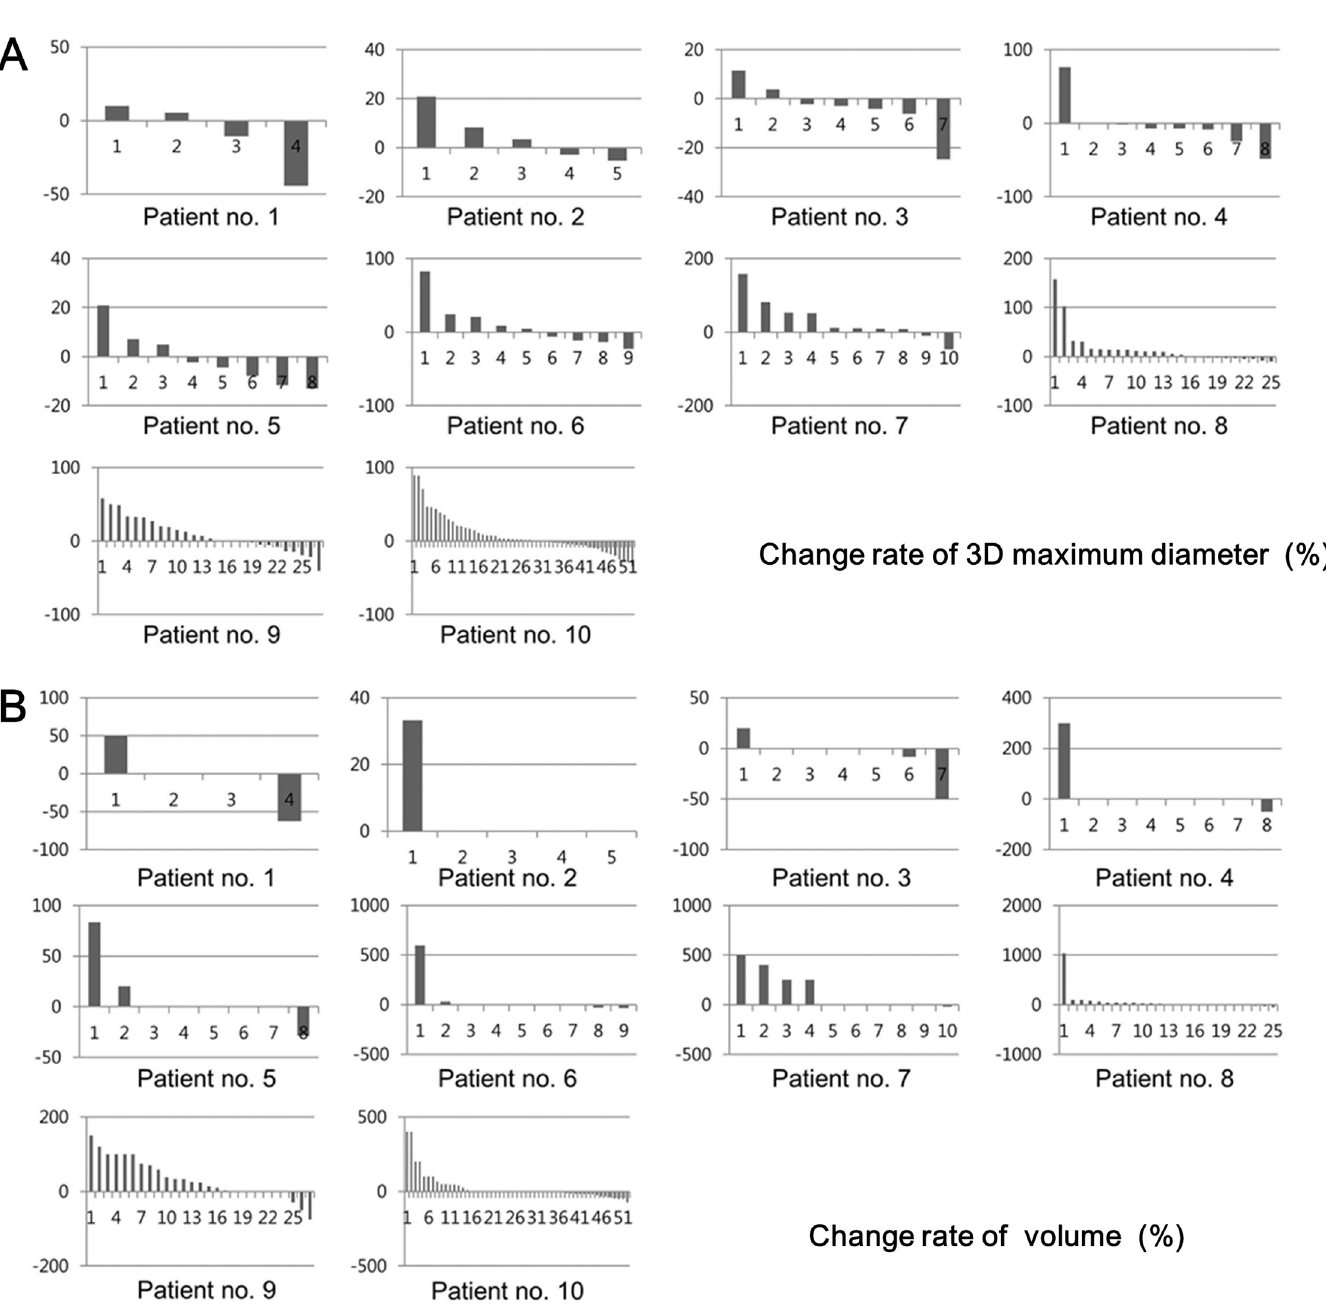
Fig 2. Change rates in 3D maximum diameter and volume of each nodule of 10 patients. Bar graphs show the change rates of each nodule in each patient regarding 3D maximum diameter (a) and volume (b). The x-axis of each patient’s graph means the number of nodules and the y-axis of each patient’s graph means the change rate (%) of each